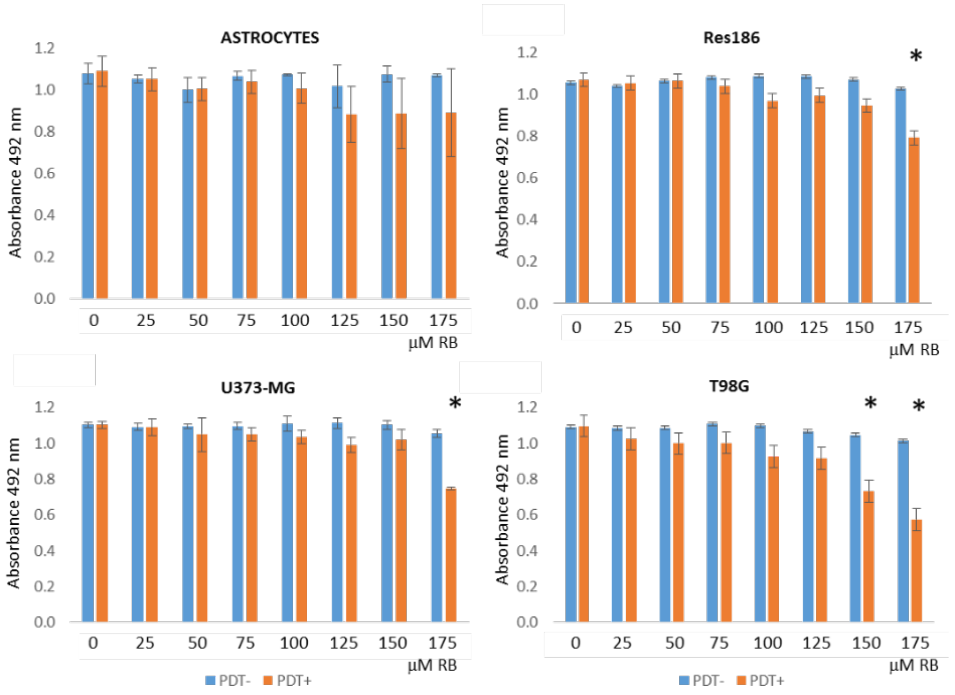
Figure 1. Cell viability MTS assays following RB and PDT treatments. Low- (i.e., Res186) and high-grade (U373-MG and T98G) human astrocytoma cells lines and normal rat primary astrocytes were treated with different concentrations of RB (0, 25, 50, 75, 100, 125, 150 and 175 μM for 24 h) exposed (PDT+) or not (PDT − ) to 562/576 nm irradiation for 5 min. Colorimetric MTS analysis, measured as absorbance at 492 nm, was carried out after 24 h p.t. All experiments were performed in triplicates with independent assays. Asterisks indicated statistical significance compared to related PDT- cells ( p < 0.05, Anova one-way; SD are highlighted as vertical bars).